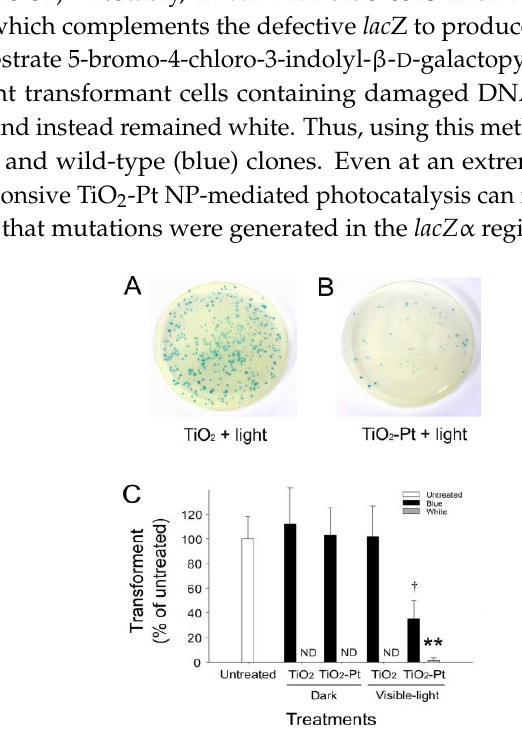
Figure 4. Detection of mutated clones using lac Z α-peptide complementation. ( A , B ) After being complemented with lac Z α-peptide expression, the transformants are displayed as blue colonies on the agar plates with 5-bromo-4-chloro-3-indolyl- β - D -galactopyranoside. The VLRP TiO 2 -Pt NP-mediated photocatalysis markedly reduces the number of transformants, compared with the control groups using UV-responsive TiO 2 NPs, under visible light illumination. ( C ) Quantified results show that TiO 2 -Pt photocatalysis can induce the formation of white colonies. This indicates that mutations hit the lac Zα region because of a loss-of-function (loss-of-complementation) phenotype, compared with the wild-type plasmid-transformed blue colonies. ND: no detected colony. * p < 0.05 vs. both blue groups of TiO 2 -visible light and TiO 2 -Pt-dark; ** p < 0.01 vs. respective blue groups. n = 6, three experiments with two replicates.